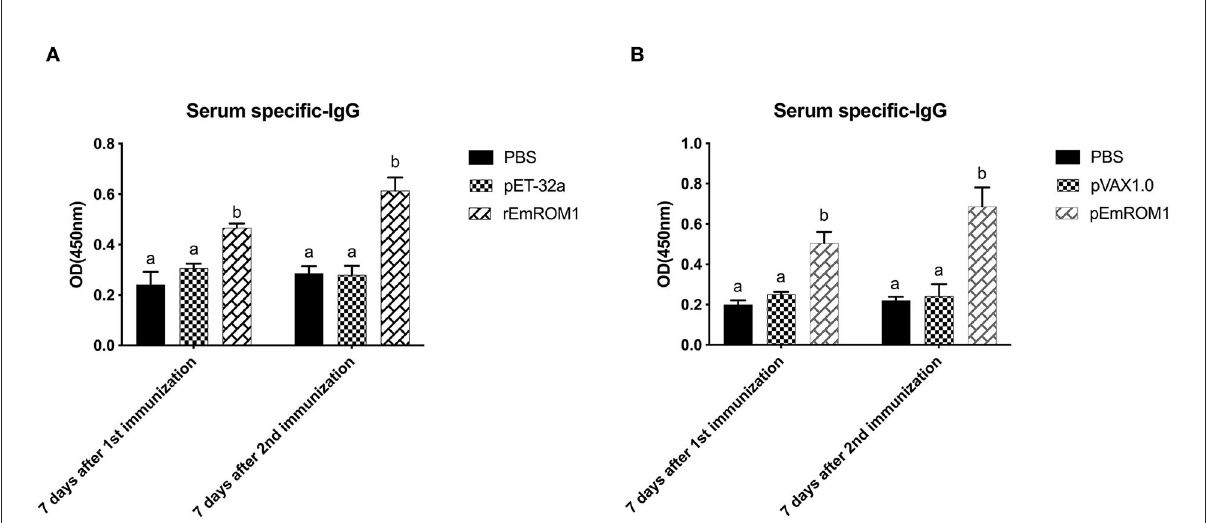
FIGURE6 Serum specific IgG after immunized with rEmROM1 or pEmROM1. (A) Serum IgG titers induced by rEmROM1. (B) Serum IgG titers induced by pEmROM1. N = 20, the error bars = standard deviation. Significant difference ( P < 0.05) between groups is marked with different letters. No significant difference ( P > 0.05) between groups is marked with the same letter.